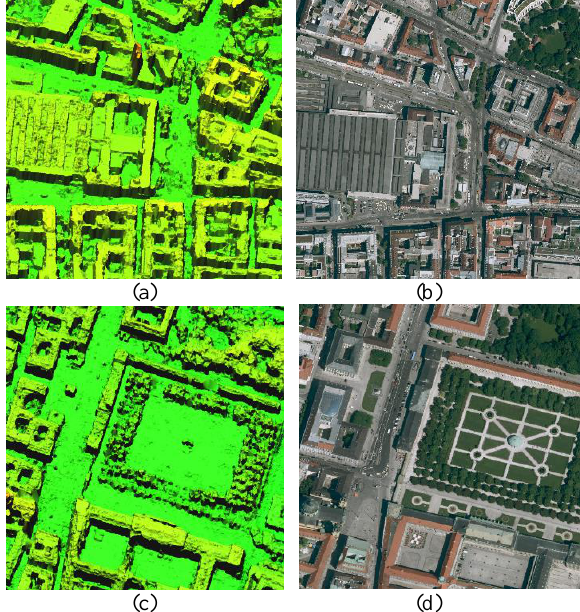
Figure 9. Detail comparison between DSM and orthophoto More quantitative analyses are conducted with the reconstructed DSM from the aerial photography and satellite imagery. Here, 20 check points on the ground and 20 check points on the roofs are selected from the aerial photography DSM.